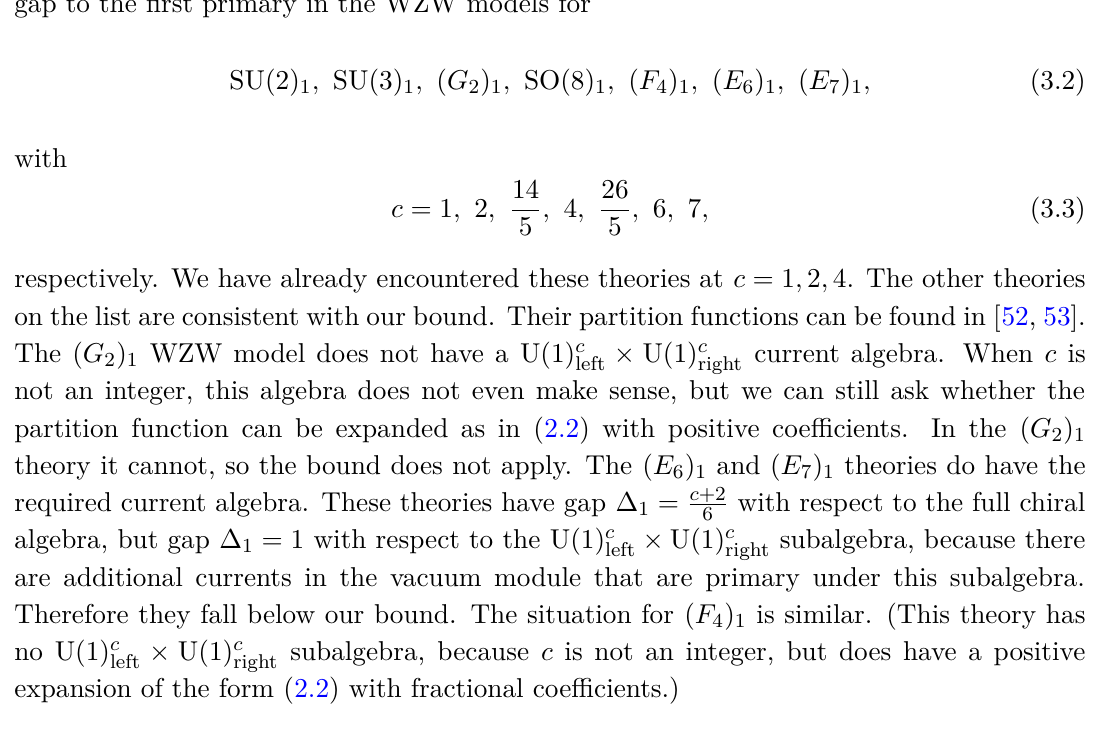
the c = 2 case as an open problem for the analytic bootstrap. It seems conceptually similar to the sharpness of the spinless bound for c = 1 , and both of these cases resist all known